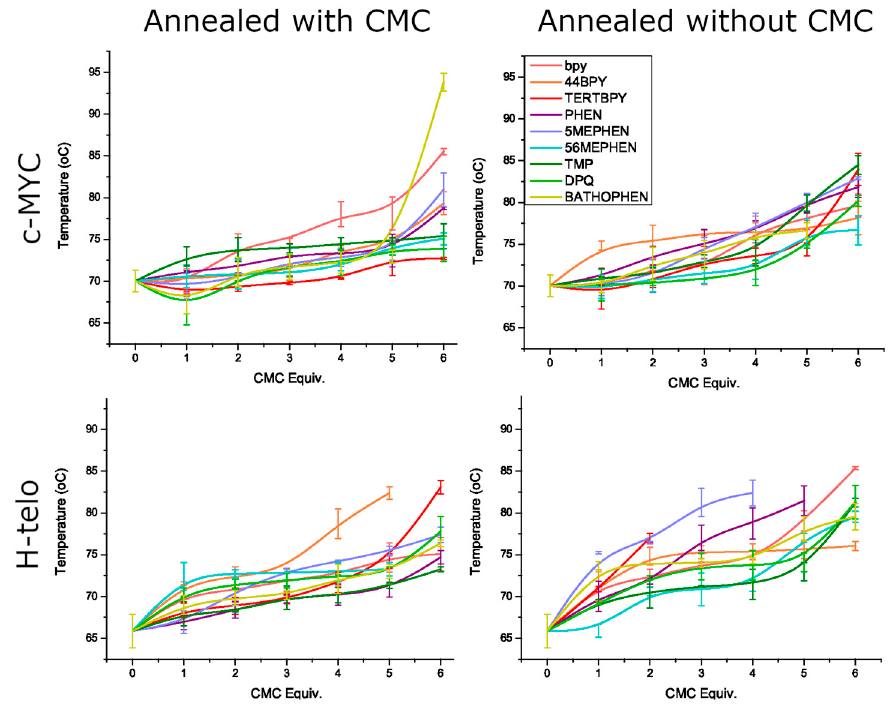
Figure 5. Δ TM of c-MYC and H-telo per equivalent of CMCs when annealed with vs. without